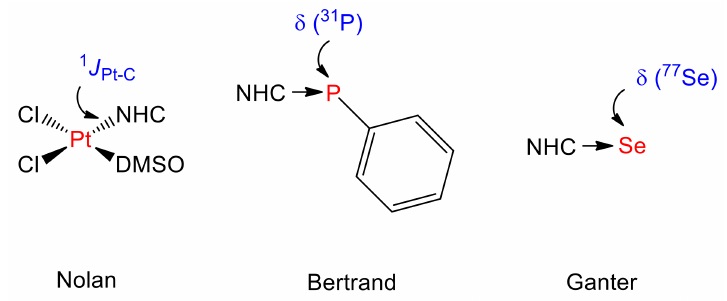
Figure 3. Techniques developed to quantify the π -acceptor properties of NHCs as proposed by Nolan, Bertrand and Ganter